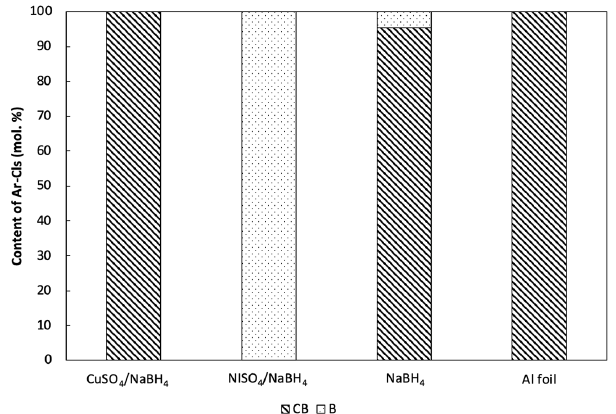
Figure 10. The composition of reaction mixture at the end of HDC of chlorobenzene CB using in situ generated Cu (CuSO 4 /NaBH 4 ), Ni (using NiSO 4 /NaBH 4 ) and comparison of action of the sole NaBH 4 and Al (for more details see Supplementary Materials, Table S3). The experimental details are described in Sections 4.2.2 and 4.2.3.